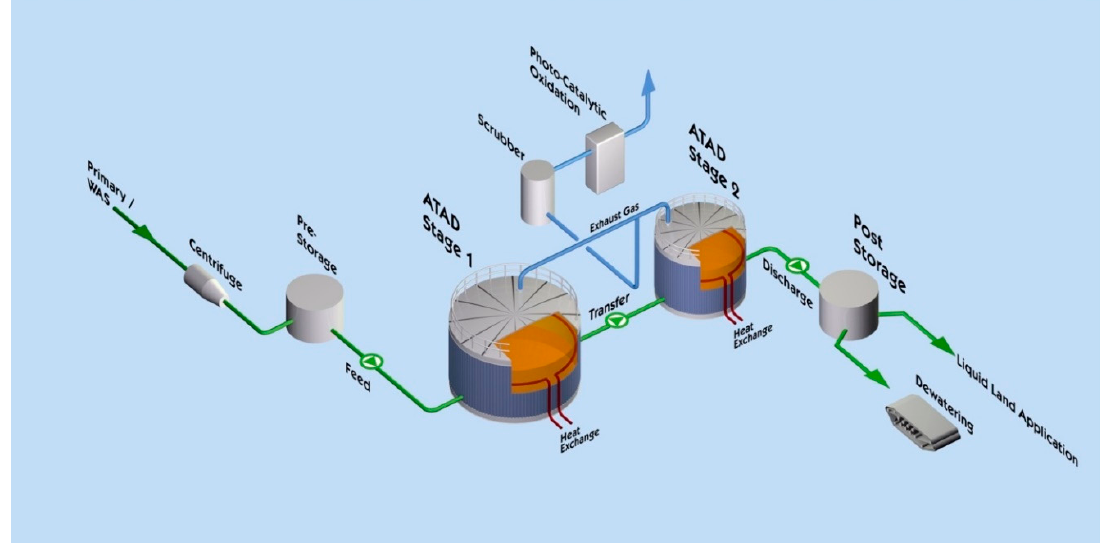
Figure 3. Diagram of a sludge node with autothermal thermophilic aerobic digestion (ATAD) [21].